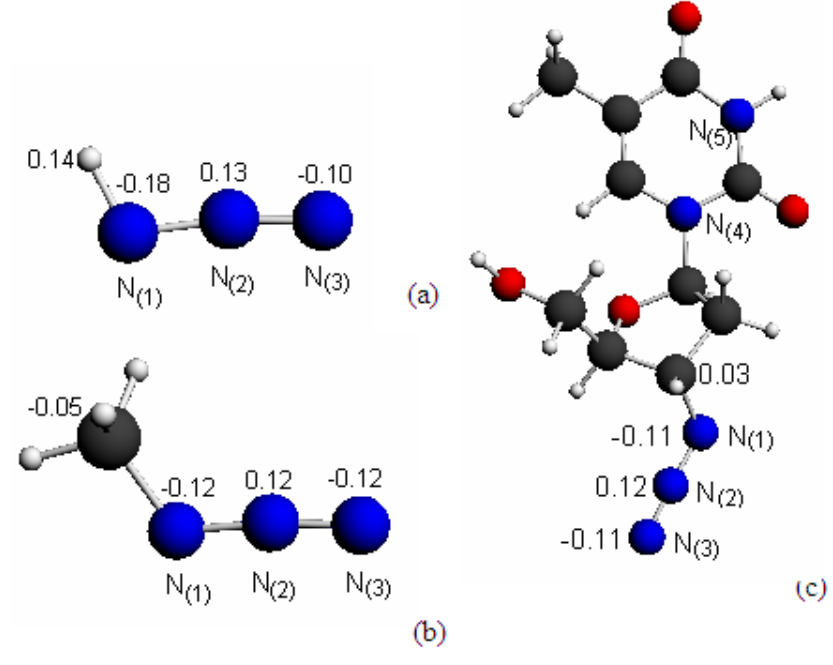
Figure 1. Structures and Hirshfeld charges of: (a) hydrazoic acid (HN3), (b) methyl azide (CH3N3) and (c) 3 ′ -azido-3 ′ -deoxythymidine